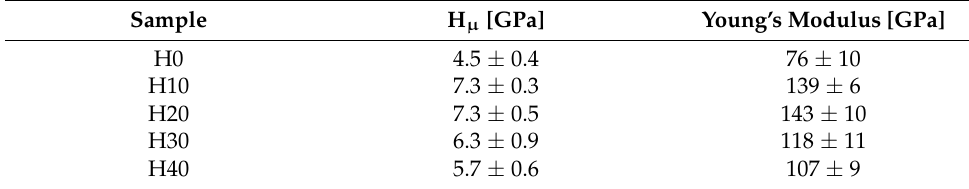
Table 7. Microhardness and Young’s modulus of the obtained coatings .